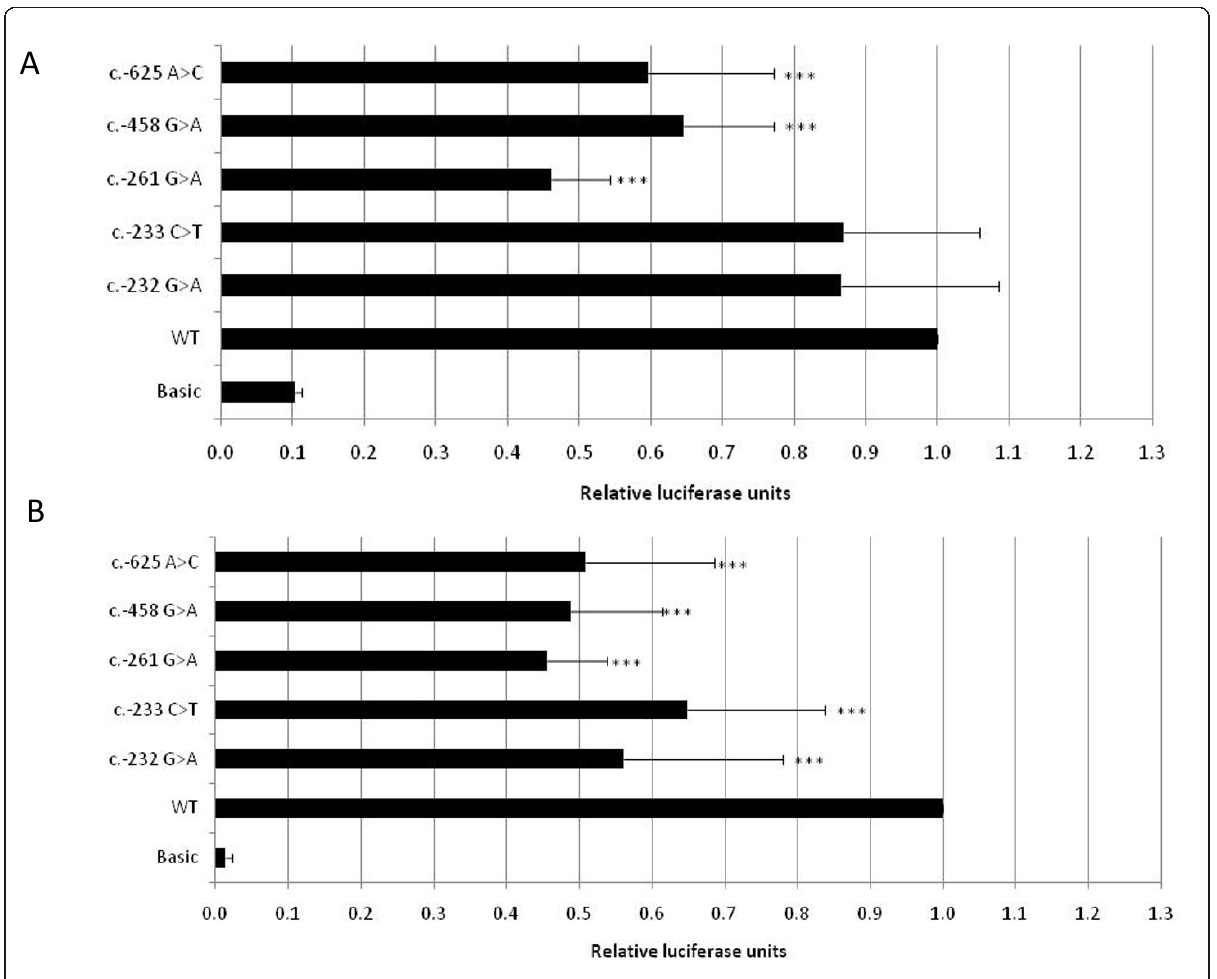
Figure 2 Luciferase activity of ZNF750 regulatory region in human primary keratinocytes . Bar chart representing luciferase activity of pGL3 constructs containing ZNF750 promoter and 5 ’ UTR variants relative to wild type promoter (WT). Four variants (c.-458G>A, c.-261G>A,